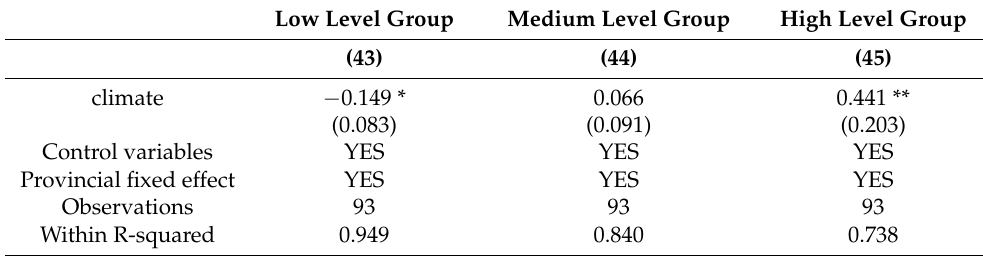
Table 10. Moderating effect of digital inclusive